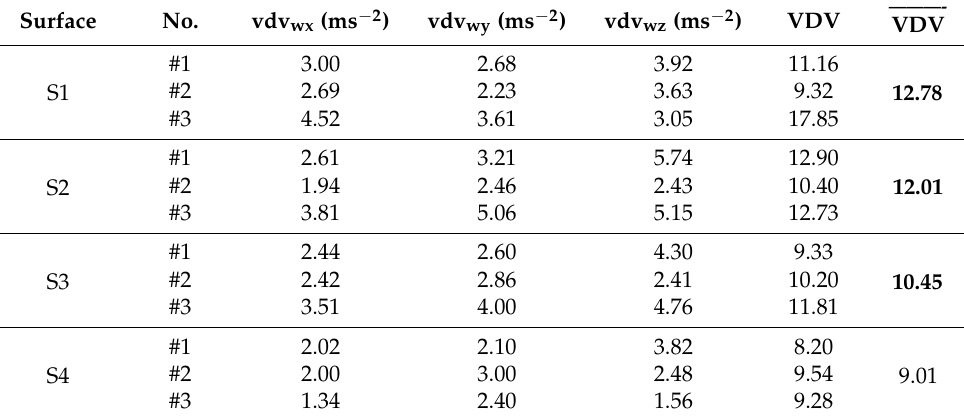
Table 7. Summary of data obtained from driver 2 according to ISO 2631-1:1997, method VDV.